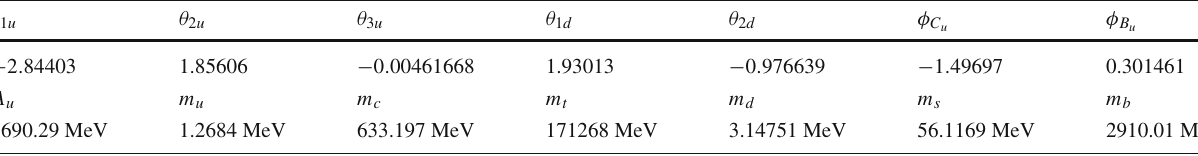
Table 5 Best fit point of the mass matrices parameters to the quark masses and mixing angles at the Z